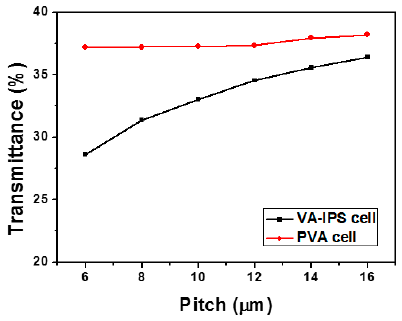
Figure 7. Calculated transmittances of VA-IPS and PVA cells as a function of patterned electrodes pitch P .